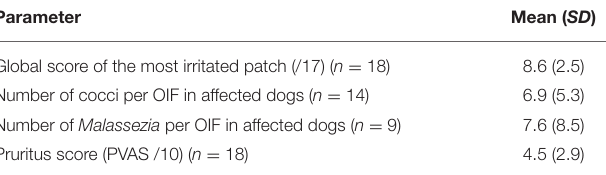
TABLE 3 | Main characteristics of the microbial overgrowth at D0.